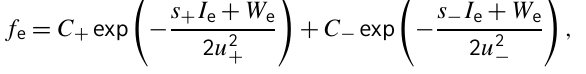
Figure 3. The magnetic field (1), where for the illustration we have Fig. 3. The magnetic field (1), where for the illustration we have assumed B z =B 0 =0 : 5 . The half period assumed B z /B 0 = 0 . 5. The half period corresponding to the CS corresponding to the CS with bell-shape B y ismarked. with bell-shape B y is